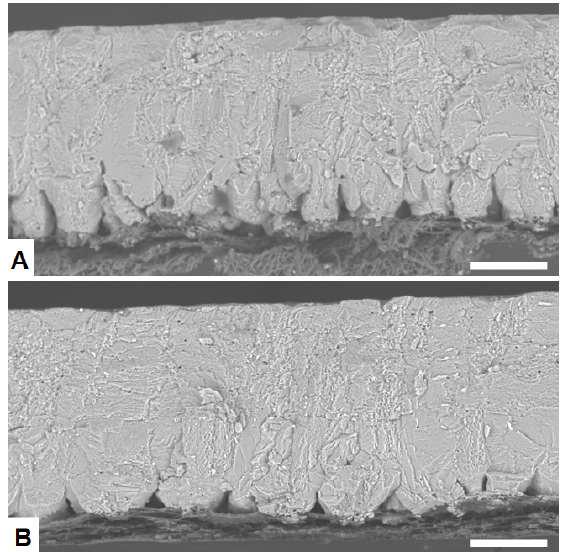
Figure 1. Representative scanning electron microscopy (backscattering electron mode (BSE-SEM)) images of the eggshell ultrastructure from: ( A ) Bad-eggshell-quality group showing late fusion of mammillary knobs; ( B ) Good-eggshell-quality group showing a denser structure. Scale bar: 100 µ m.